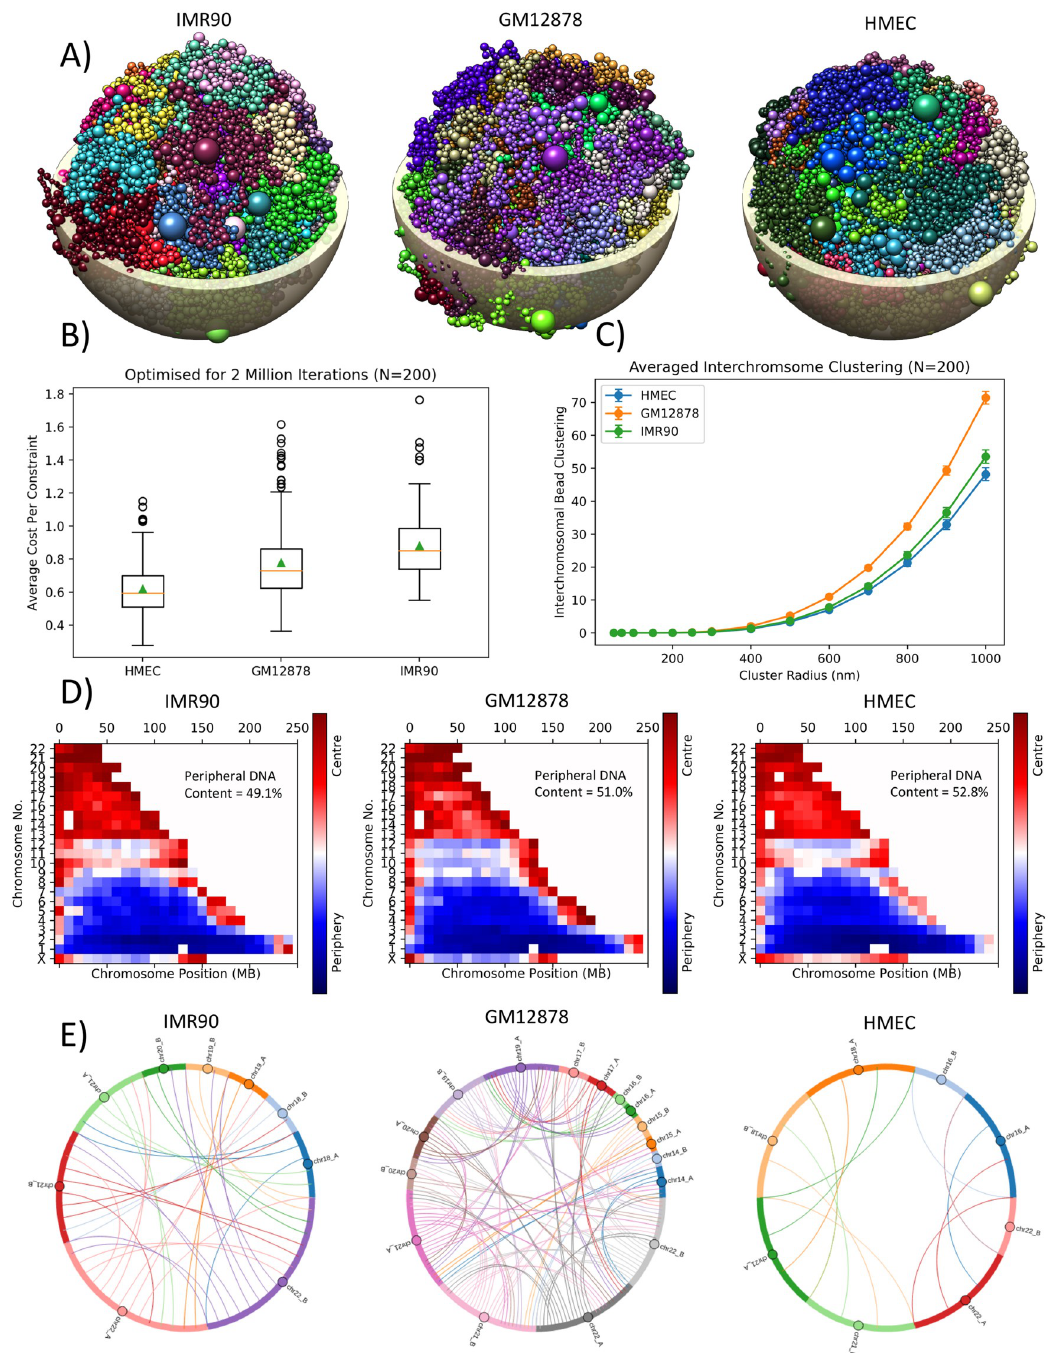
Fig 2. Geometrical properties of the inferred 3D spatial chromatin arrangement. A) rendered 3D example geometries for different cell-type Hi-C data. Each colour represents different chromosomes and the bead size represents the amount of DNA content. Rendered nuclear shell is to give an idea of scale for a 5 μ m radius spherical nucleus. B) evaluation of G-NOME’s ability to optimise the geometries of different Hi-C datasets. The cost function has been normalised to the total number of constraints which differs between cell types. Orange line represents the median and green triangle is the mean of the distribution. C) The resultant bead clustering for an increasing cluster inclusion radius. D) chromatin positioning within the nucleus for the different cell lines. Beads are scored based on being within the central or peripheral half of the nuclear sphere and is averaged over a 10 Mbp bin. The overall percentage of DNA content placed in the periphery is displayed within each plot. E) each line represents chromosomes that have interchromosomal beads within a 500 nm radius of one another. Lines are only displayed for the chromosomes that